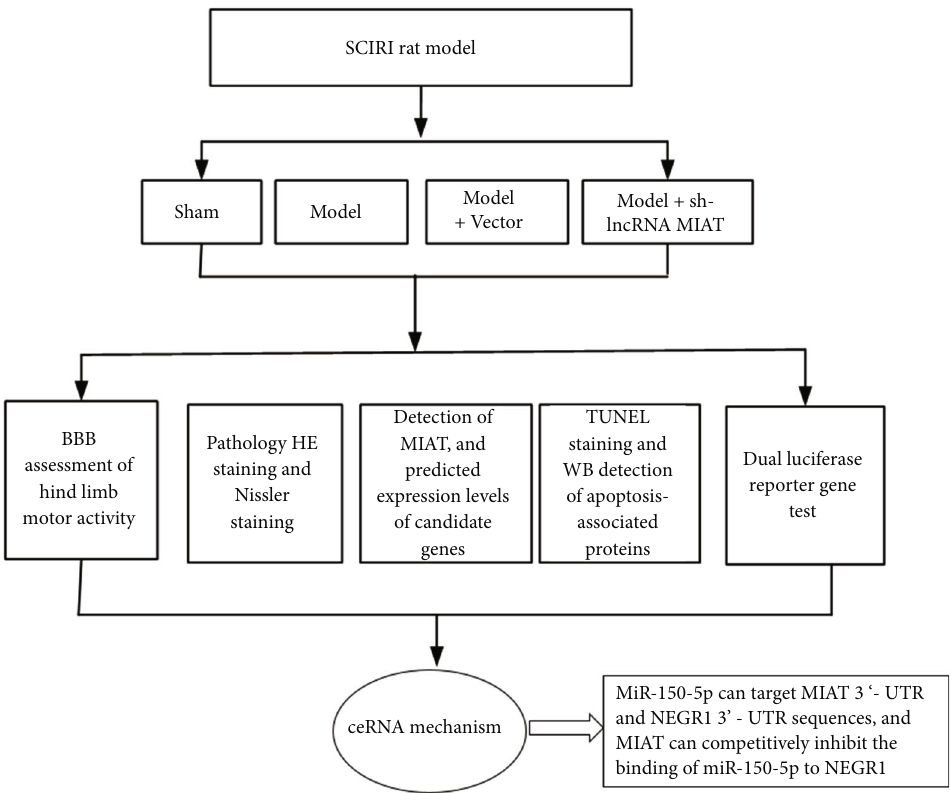
Figure 1: Flowchart of this